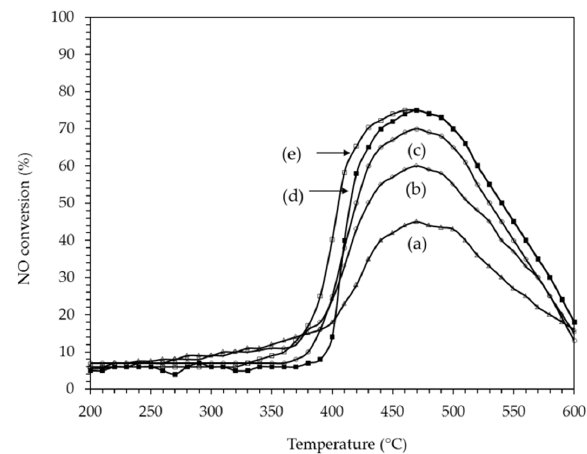
Figure 8. C 3 H 8 –SCR–NOx from ( a ) 1PtAg / AW catalyst; ( b ) 0.4PtAg / AW catalyst; ( c ) 0.25PtAg / AW catalyst; ( d ) 2Ag / AW catalyst; ( e ) 0.1PtAg / AW catalyst. Inlet gas composition: 500 ppm NO, 625 ppm C 3 H 8 , 200 ppm CO, 2vol.% O 2 , N 2 balance; GHSV = 128,000 h − 1 .